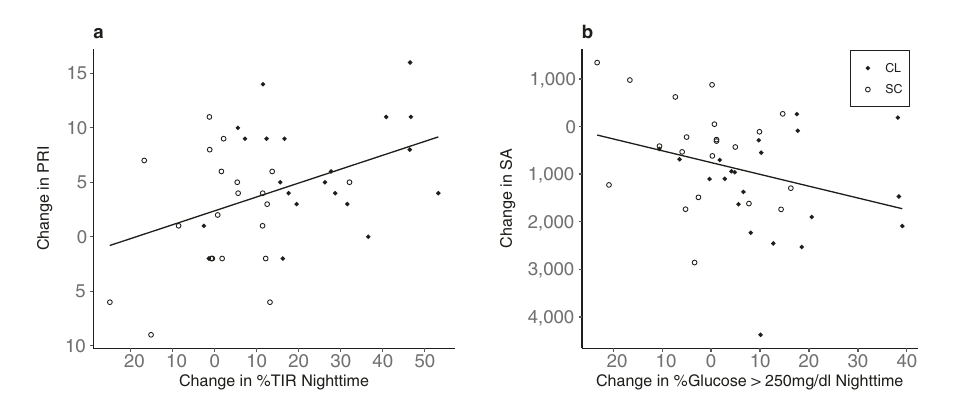
Fig. 5 | Moderator of treatment effect on cognitive trajectories. % Glucose >250mg/dl as a moderator of treatment effect on Full-Scale IQ (FSIQ): a overall intention-to-treateffectinthetotalsample. b Baseline%glucose>250mg/dl<=25%.